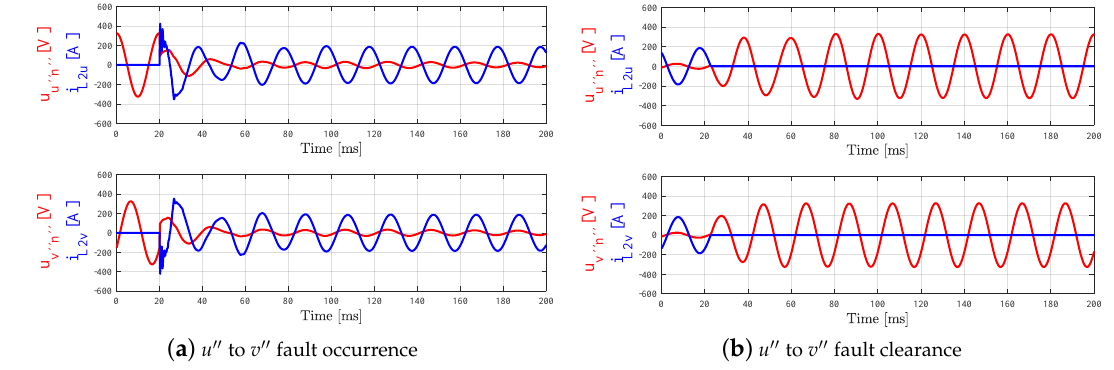
Figure 13. Scenario 2 (phase to phase short-circuit fault).